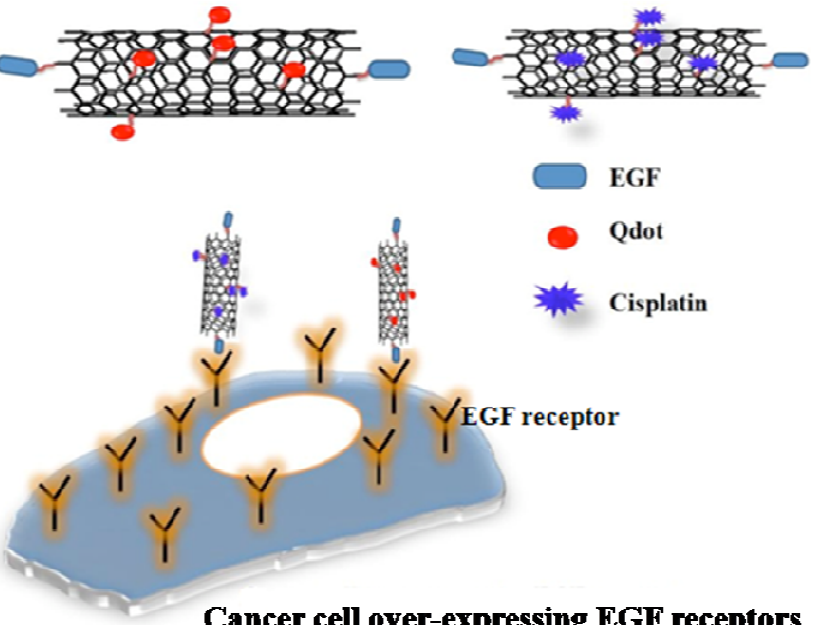
Figure 3. EGF directed killing of cancer cells using single walled carbon nanotube (SWCNT)-cisplatin delivery vector. Nanotubes coated with EGF ligand bind to the cognate EGF receptor on the cancer cell surface and internalize via receptor-mediated